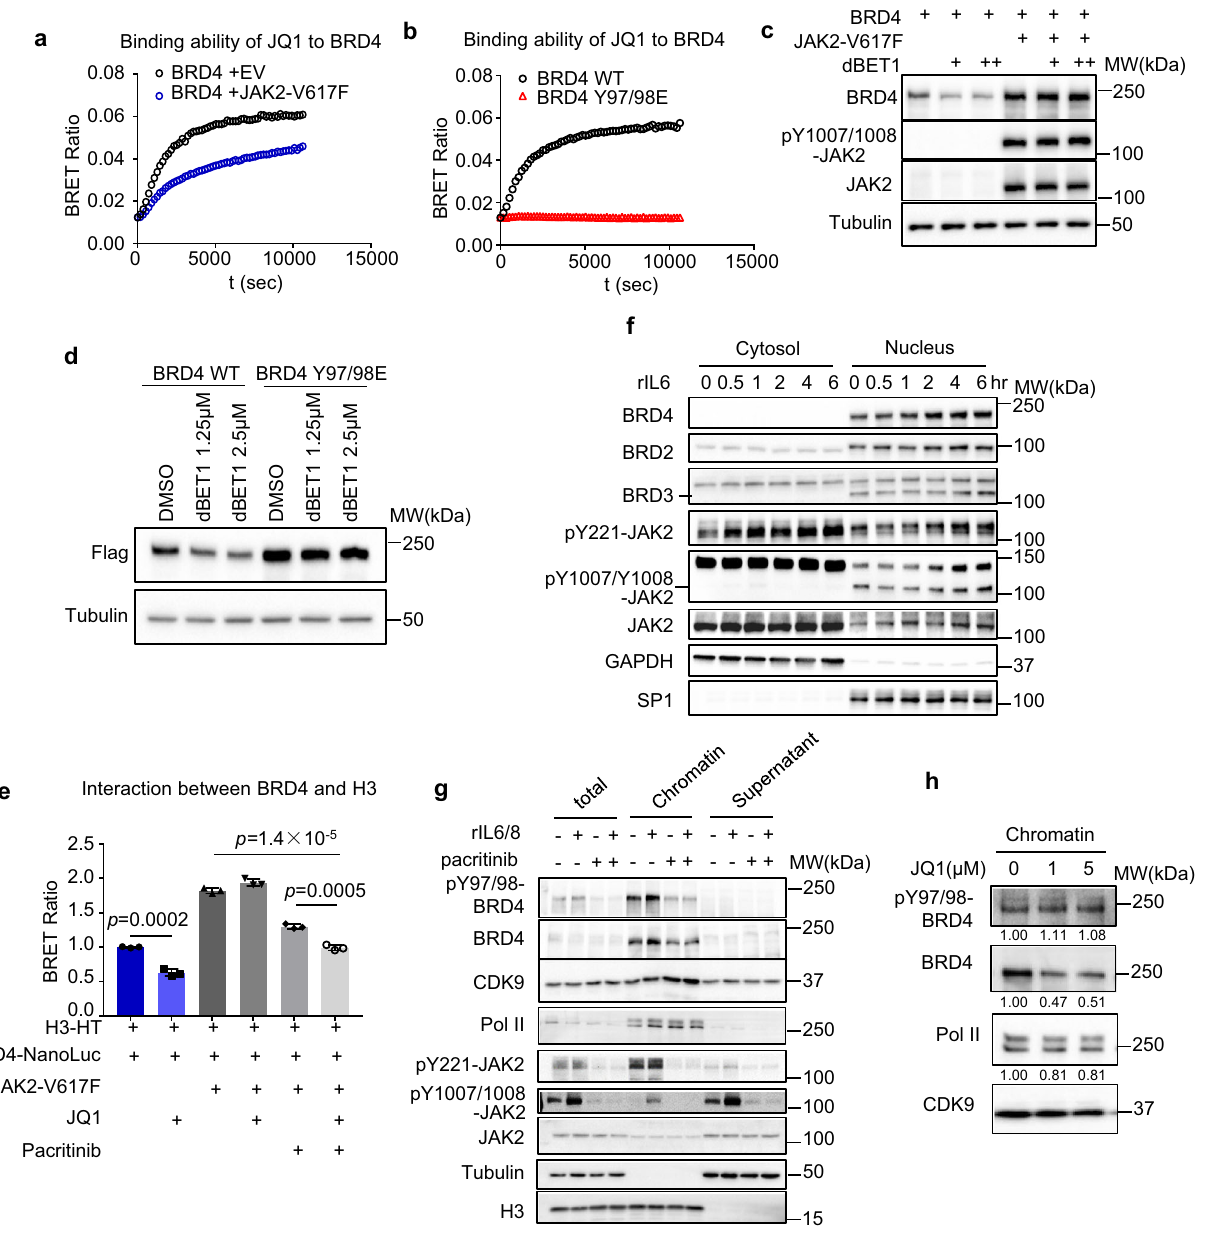
Fig. 6 BRD4 phosphorylation at Y97/98 modulates its binding to chromatin and BET inhibitor. a NanoBRET report assay determining the binding ability of JQ1 to BRD4 in 293T cells transfected with BRD4 and active JAK2-V617F or empty vector. b NanoBRET report assay determining the binding ability of JQ1 to BRD4 in 293T cells transfected with BRD4-wild-type or BRD4-Y97/98E. c Representative western blot analysis ( n = 3) of indicated proteins in 293T cells transfected with indicated constructs and treated with dBET1(1.25 μ M, 2.5 μ M). d Representative western blot analysis ( n = 3) of indicated proteins in 293T cells transfected with fl ag-BRD4 or fl ag-BRD4-Y97/98E followed by dBET1 treatment. e NanoBRET ™ BRD4/Histone H3.3 Interaction Assay in 293T cells determining the interaction between BRD4 and histone H3.3 under different conditions. 293T cells were transfected with BRD4- NanoLuc and histone H3.3-HaloTag with/without active JAK2-V617F as indicated, then were treated with indicated inhibitors. f Representative western blot analysis ( n = 2) of indicated proteins from cytosol and nucleus of PDC1 cells treated with 20 ng/ml rIL6 for indicated time. g Representative western blot analysis ( n = 3) of indicated proteins from WCL, chromatin, and supernatant of PDC1 cells treated with 50 ng/ml rIL6/8 and/or 2.5 μ M pacritinib. h Representative western blot analysis ( n = 2) of indicated protein from chromatin of PDC1 cells treated with 20 ng/ml rIL6 followed by JQ1 treatment. In e , data is presented as the mean ± SD (error bars) of three biological replicates. The p values were determined using two-tailed Student ’ s t